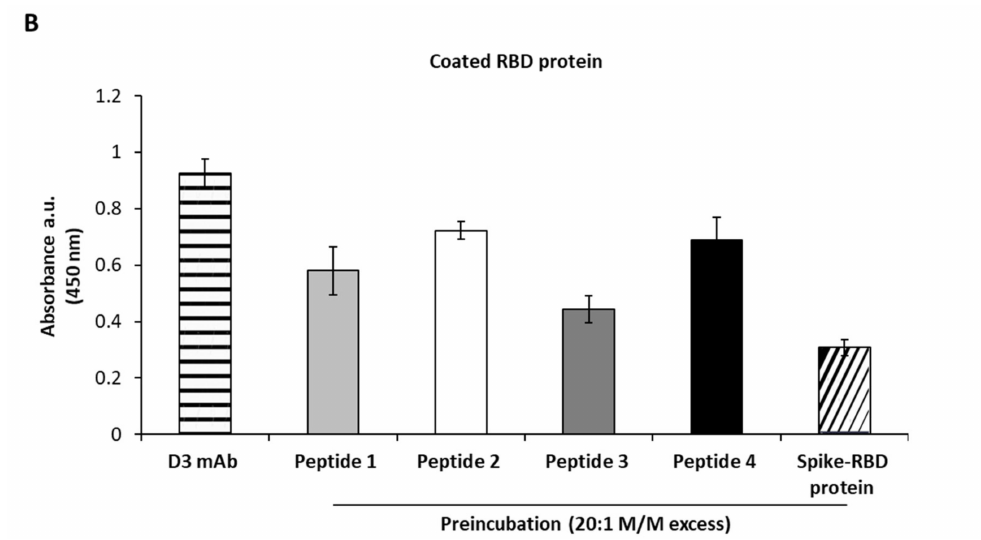
Figure 1. ELISA assays to test the binding of D3 to different peptides derived from Spike-RBD domain. ( A ) The peptides were immobilized on a 96-well plate at the concentration of 5 µ g/mL and incubated with D3 mAb or ACE-2 receptor at the concentration of 150 and 300 nM. ( B ) The binding of D3 was detected on an immobilized RBD protein in the absence (striped bar) or in the presence of peptide 1 (light gray bar), peptide 2 (white bar), peptide 3 (dark gray bar), peptide 4 (black bar) or Spike-RBD protein (slashed bar), used at 20:1 molar excess with respect to mAb. Binding values were reported as the mean of at least three determinations. Error bars depicted means ± SD.